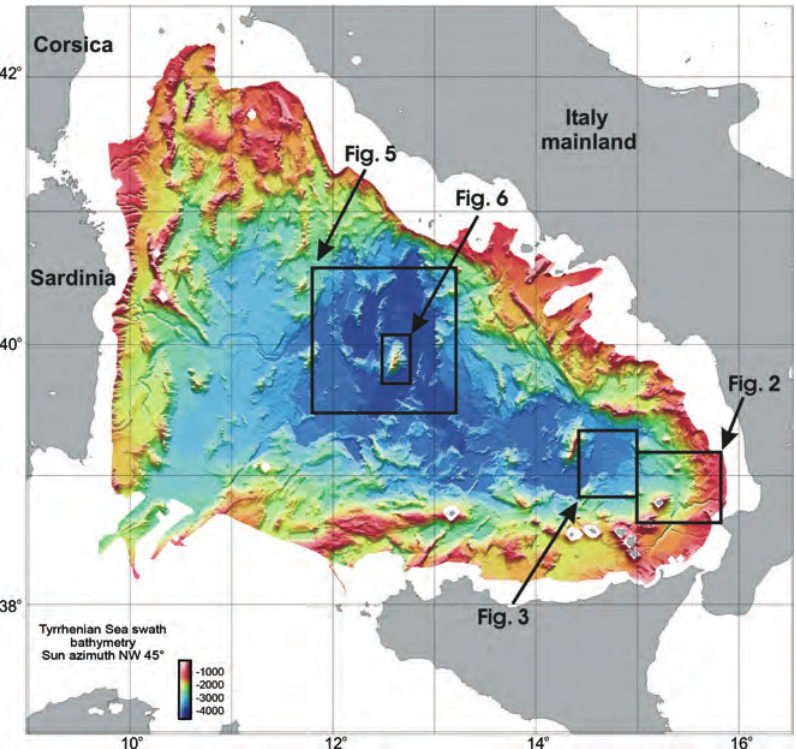
Fig. 1. Colour-shaded bathymetric map of the Tyrrhenian Sea. The areas targeted by the investigations carried out during the VST02 (boxes) are detailed in the subsequent